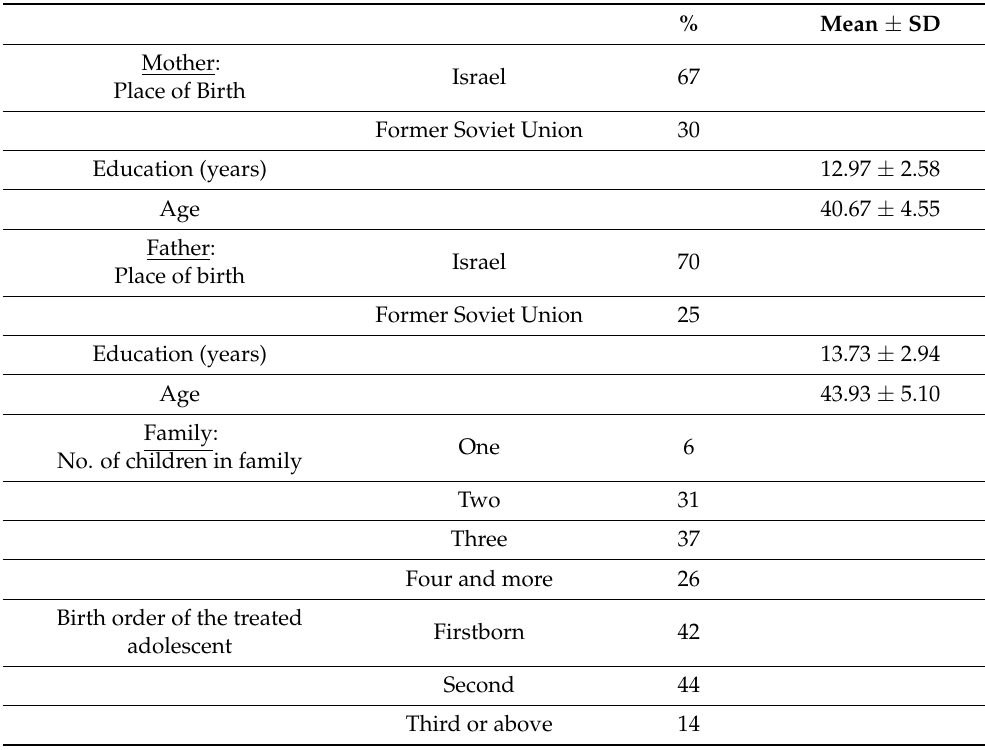
Table 1. Family demographic